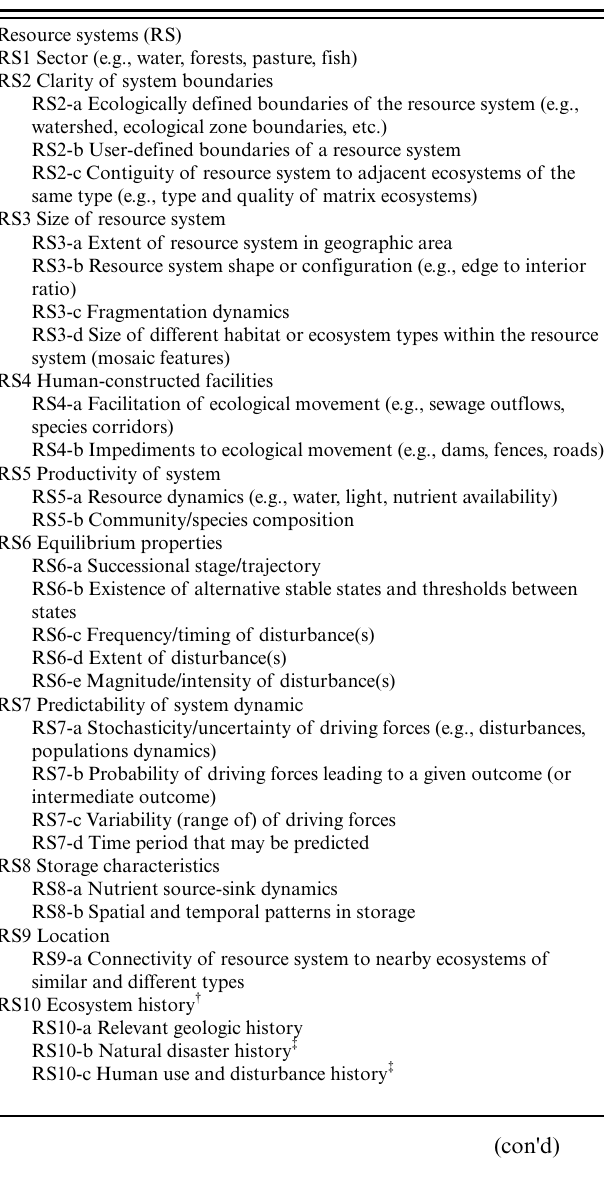
Table 2 . Proposed ecological attributes (numbered RS2-a, RS2-b, etc.) in the Resource System (RS) and Resource Unit (RU) core subsystems, to explicitly incorporate ecological principles into the social-ecological system (SES) framework.